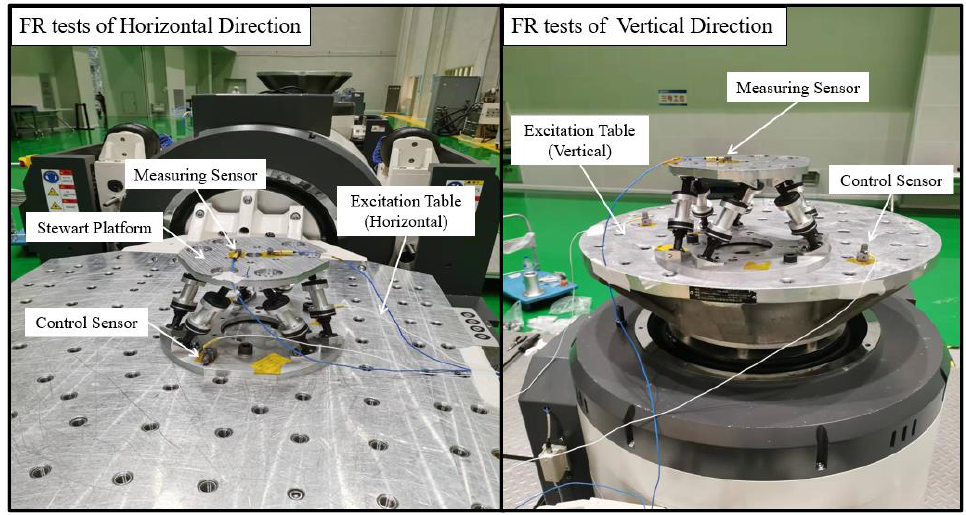
Figure 8. Frequency response tests of Stewart platform.